Question: Identify the chart type used in this figure.
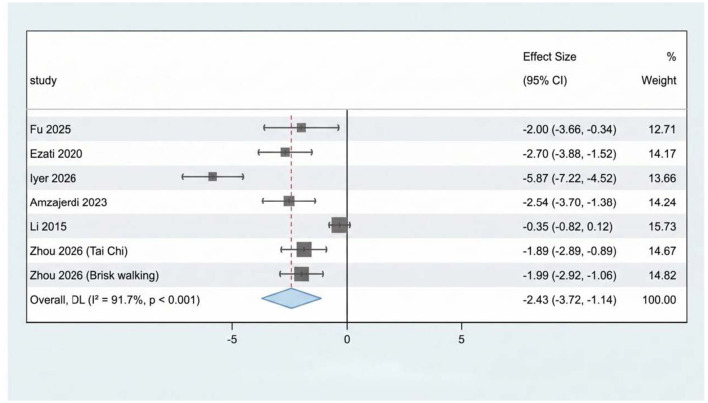
Answer: forest